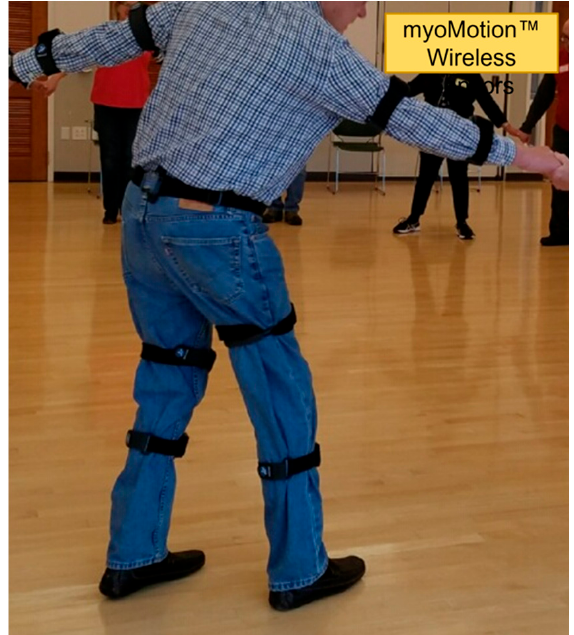
Figure 1. Dance students wore the Noraxon myoMOTION™ devices for a one-hour long session. These devices were attached to the arm, forearm, hip, thigh, and leg, and activated during each dance practice.